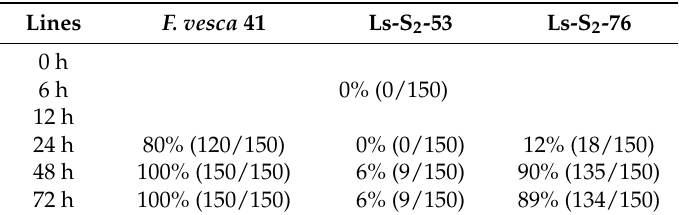
Table 2. The proportion of styles traversed by at least one pollen tube.